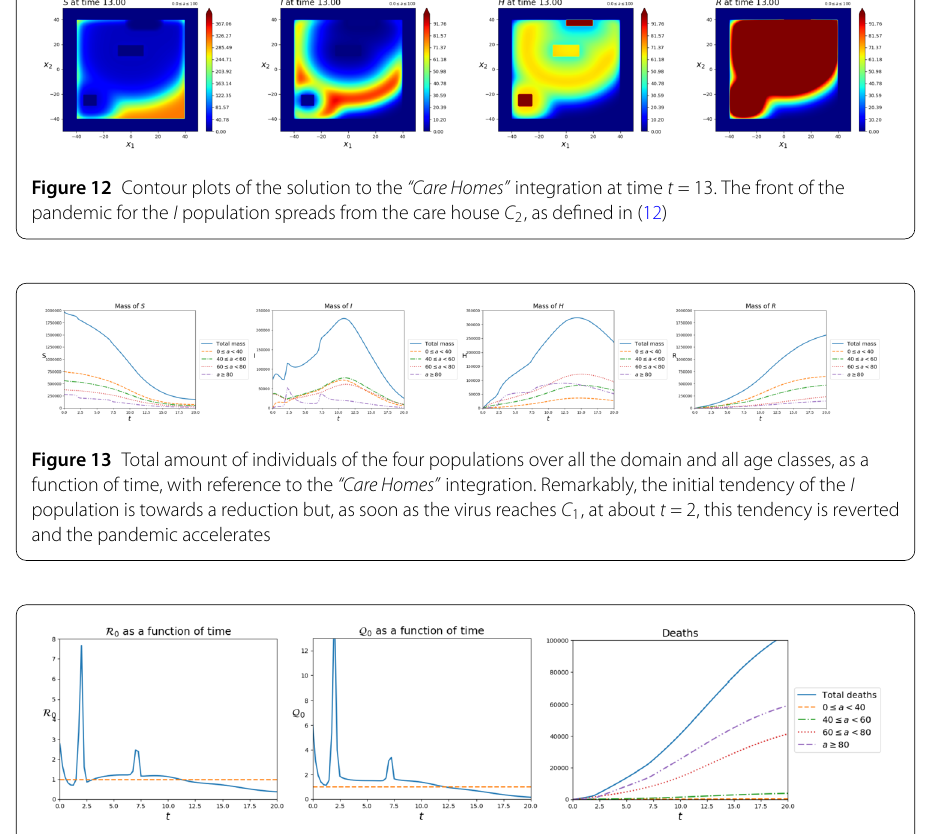
Figure 14 R 0 , left, and Q 0 , middle, indexes as a function of time in the simulation of the “CareHomes” case. The epidemic outbreaks in C 1 and C 2 are clearly visible. Right, the total number of deaths due to the pandemic, as a function of time, also separated in the 4 age classes. As expected, the oldest fraction of the population pays the highest